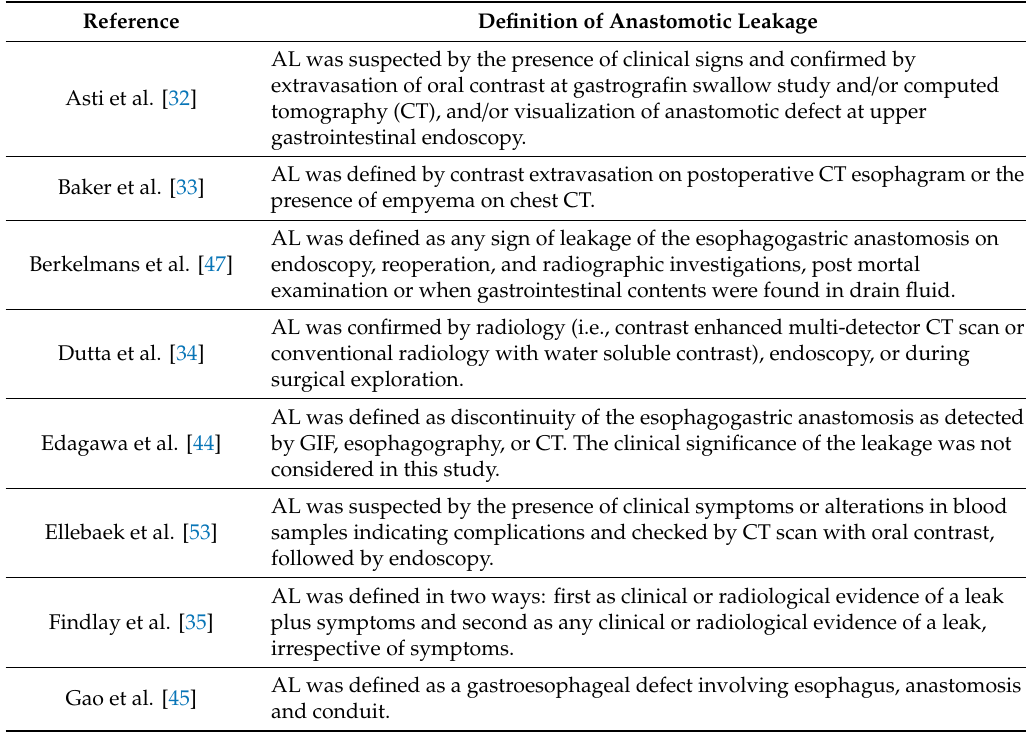
Table 2. Reported definitions of anastomotic leakage.